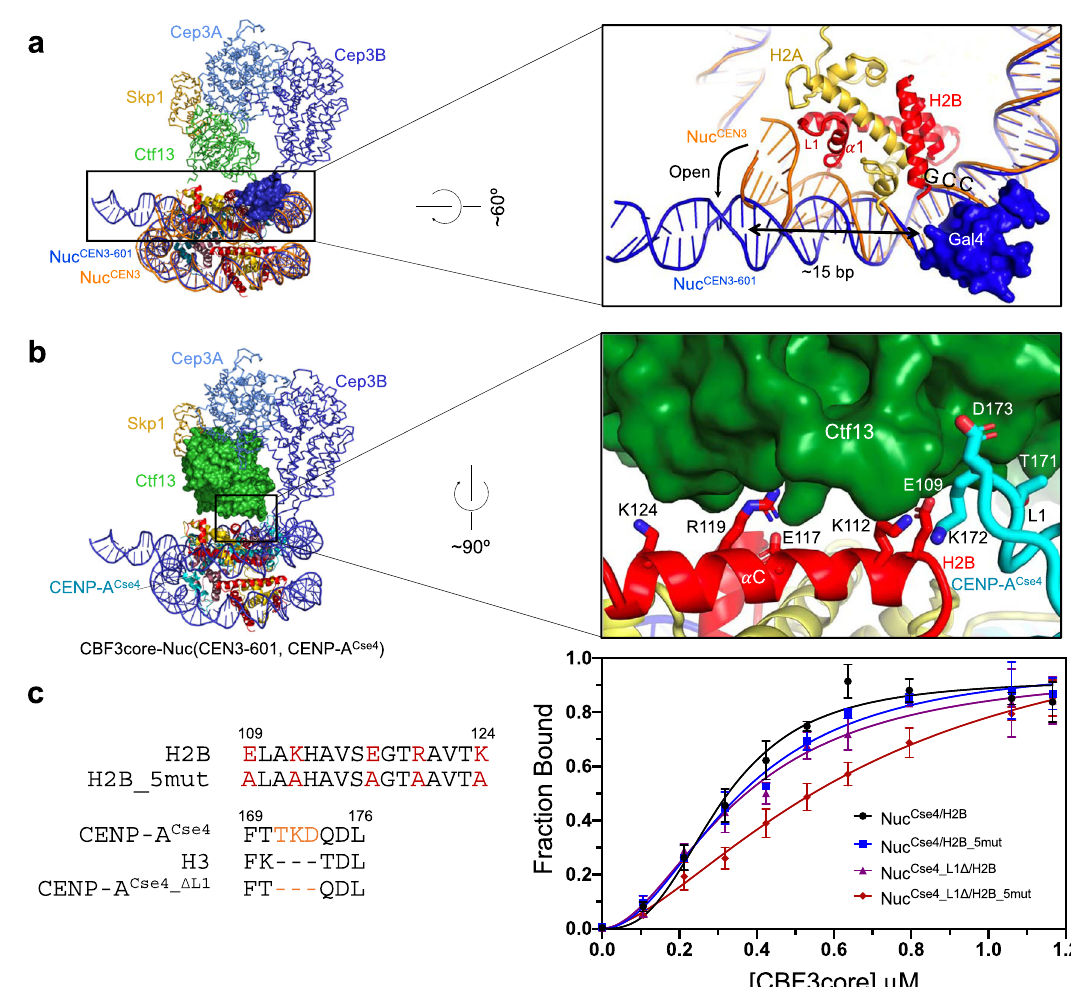
Fig. 3 Interactions between CBF3core and the nucleosome. a Allosteric effects of Gal4 domain binding on DNA. The structures of the CBF3core – nucleosome complex and the free CEN3 nucleosome were aligned on the core histones. DNA in the CBF3core – nucleosome complex is colored blue and DNA in CEN3 nucleosome is colored orange. Gal4 domain is shown in blue surface. b A structural model for interactions between the core histones and CBF3core in one conformation. H3 in the CBF3core – CEN3-601 nucleosome structure was substituted by CENP-A Cse4 in the CEN3 CENP- A Cse4 nucleosome though alignment of the backbones of core histones. In the model, the residues in the α 2 helix of H2B histone and loop 1 of CENP-A Cse4 are close to the Ctf13 subunit of CBF3core (green surface). c Measurement of the effects of histone mutations on the binding af fi nity between CBF3core and the CEN3 CENP-A Cse4 nucleosome. Mutant H2B_5mut had the fi ve residues (Glu109, Lys112, Glu117, Arg119, and Lys124 in sticks) in the α 2 helix of H2B (red) were mutated to Alanine. Mutant CENP-A Cse4_ Δ L1 had three residues (Thr171, Lys172, and Asp173 in sticks) in the L1 loop of CENP-A Cse4 (cyan) deleted. Nitrogen and oxygen atoms for the mutated residues are shown in blue and red colors, respectively. The K d of CBF3core binding to Nuc Cse4/H2B , Nuc Cse4/H2B_5mut , Nuc Cse4_ Δ L1/H2B , Nuc Cse4_ Δ L1/H2B_5mut are 0.32 ± 0.06 µ M, 0.35 ± 0.05 µ M, 0.36 ± 0.05 µ M, and 0.68 ± 0.04 µ M. Data were presented as mean values. Error bars represent standard deviation values from three ( n = 3) independently performed experiments. Source data are provided in the Source Data fi